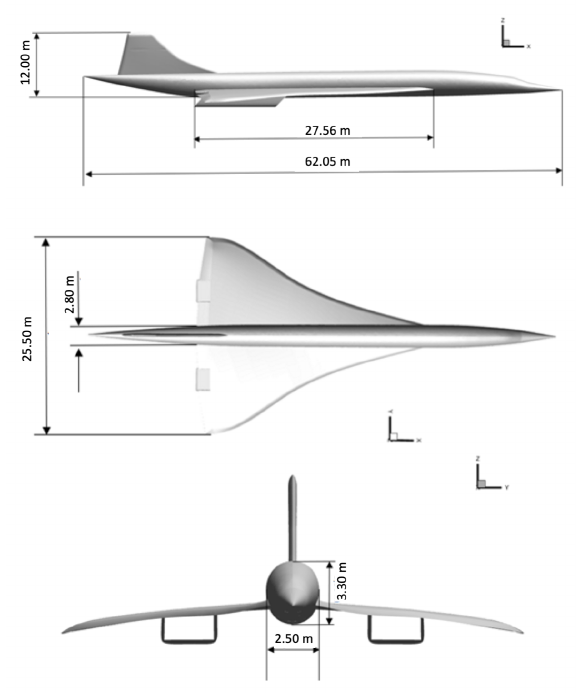
Figure 3. Aircraft